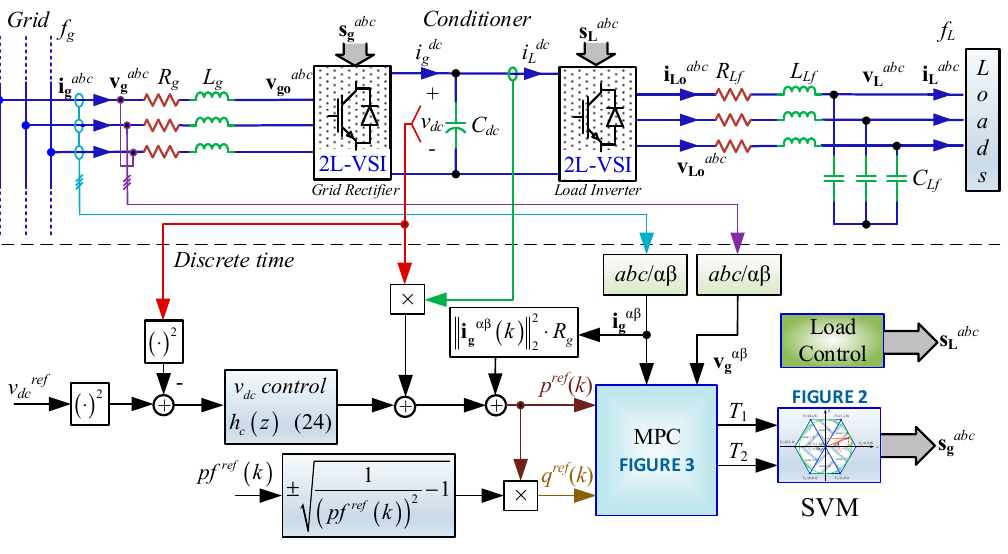
Figure 1. Power converter system.